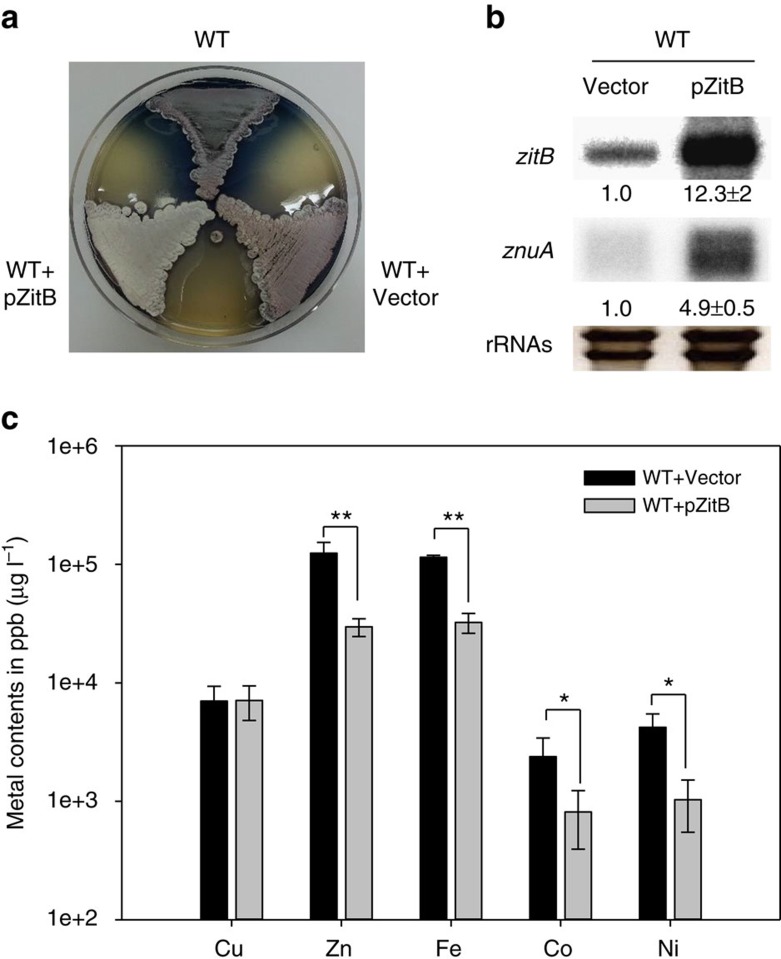
Overexpression of zitB hinders differentiation and causes a decrease in the content of Zn as well as Fe, Co and Ni.(a) The ermEp::zitB construct on pSET162 plasmid (pZitB) was introduced into the chromosome of the wild-type S. coelicolor. The pZitB containing strain showed defect in sporulation (white phenotype) and antibiotic production, whereas the wild-type strain with or without the empty vector (pSET) demonstrated grey spore formation and blue antibiotic production. (b) Expression of the zitB and znuA genes in pZitB containing strain. The zitB and znuA transcripts were analysed by S1 mapping. The band intensity was quantified and presented as relative values obtained from three independent experiments and measured with P values of <0.001 by Student's t-test. (c) Intracellular amounts of divalent cations (Cu, Zn, Fe, Co and Ni) in the wild-type cells with empty pSET162 vector or pZitB, as assayed by ICP-MS analysis. Mn and Cd were not detected. Average values from three biologically independent samples were presented in ppb (μg per litre wet mycelium) with error bars representing s.d.'s. * and ** indicate measurements with P values of <0.05 and 0.001, respectively, by Student's t-test.